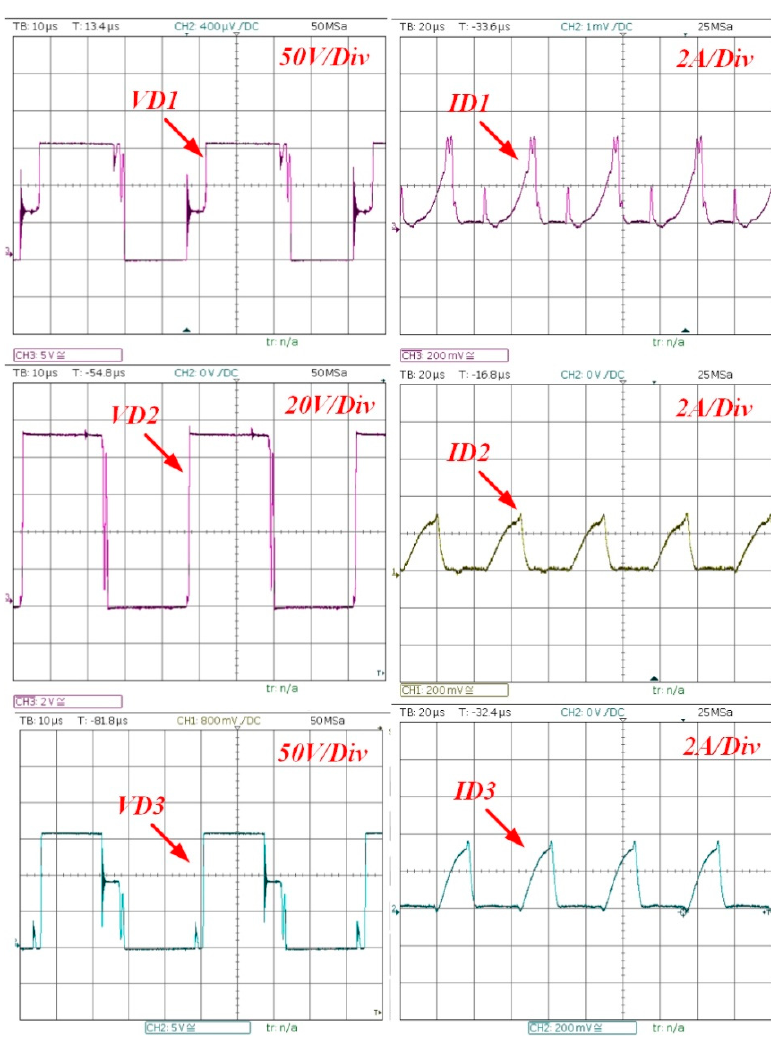
Figure 15. Currents of Diodes 1, 2, and 3.